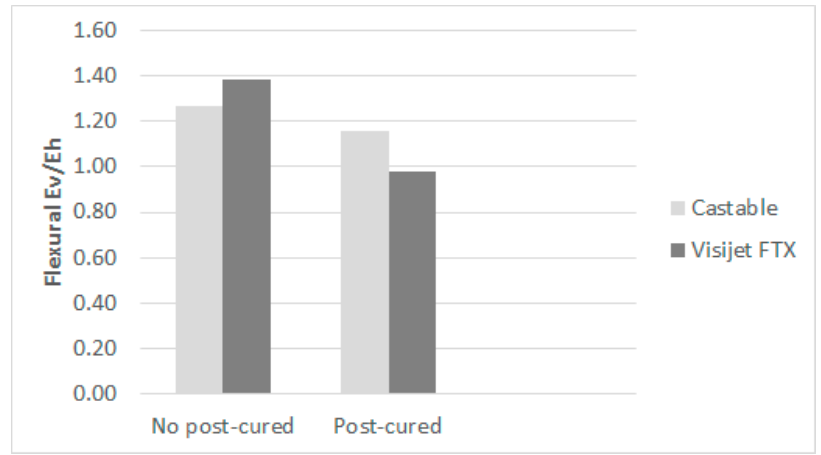
Figure 10. Anisotropy rate. Ev: vertical. Eh: horizontal.